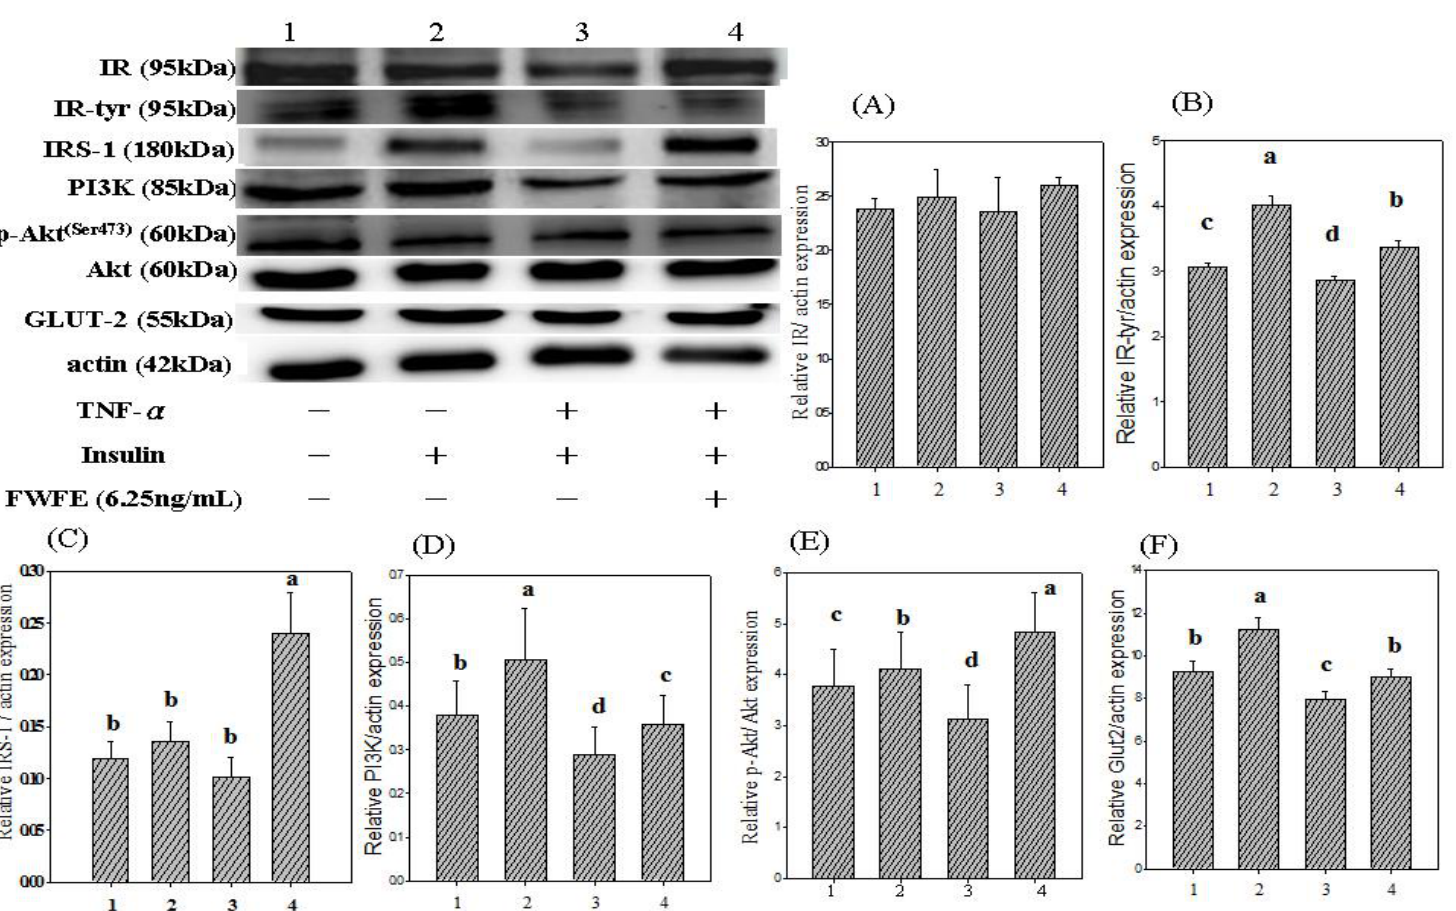
Figure 3. Effect of FWFE on TNF- α -induced inhibition of insulin signals in FL83B cells. FL83B cells were incubated in serum-free F12K medium, with or without added TNF- α (20 ng/mL), incubated at 37 °C for 5 h, transferred to another serum-free F12K medium with or without insulin (1000 nM), FWFE (6.25 μ g/mL), and then incubated for an additional 30 min. The basal level of glucose uptake was evaluated by incubating cells with the serum-free F12K medium. The relative expressions of IR, IR-tyr, IRS-1, PI3K (p85), p-Akt/Akt, and GLUT-2 in each treatment group were calculated using actin as the standard. Letters a~d indicate significant differences at 5%